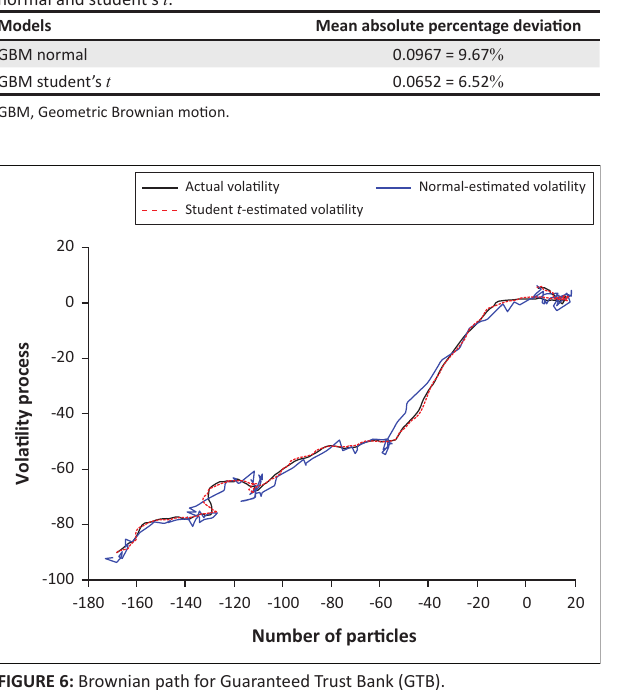
FIGURE 6: Brownian path for Guaranteed Trust Bank (GTB).